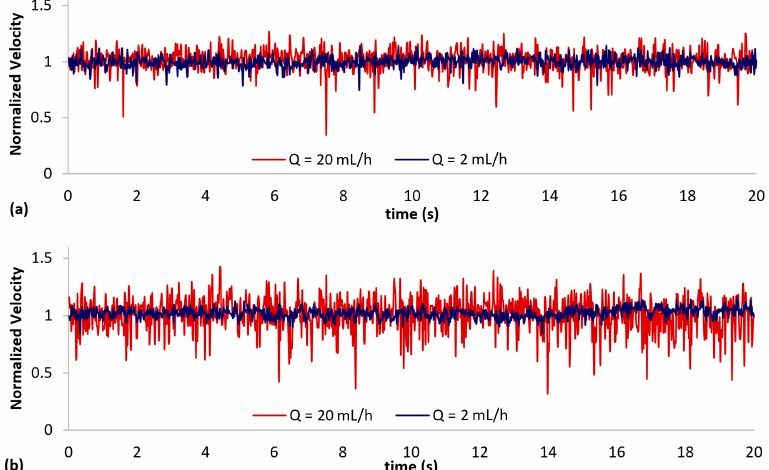
Figure 11. Normalized low frequency axial velocity measurements at ( a ) interrogation window A ( δ